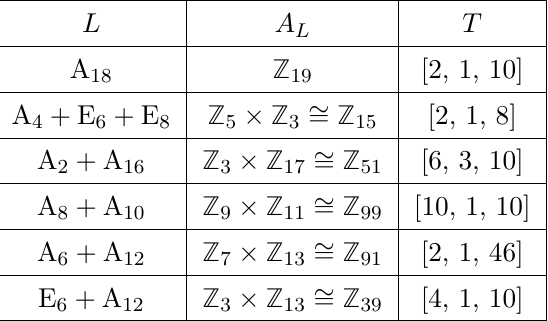
Table 2. Examples of allowed L with ‘ ( A L ) = 1, when d = 2. T is denoted by its Gram matrix [ u 2 ; u 1 (cid:1) u 2 ; u 2 1 2